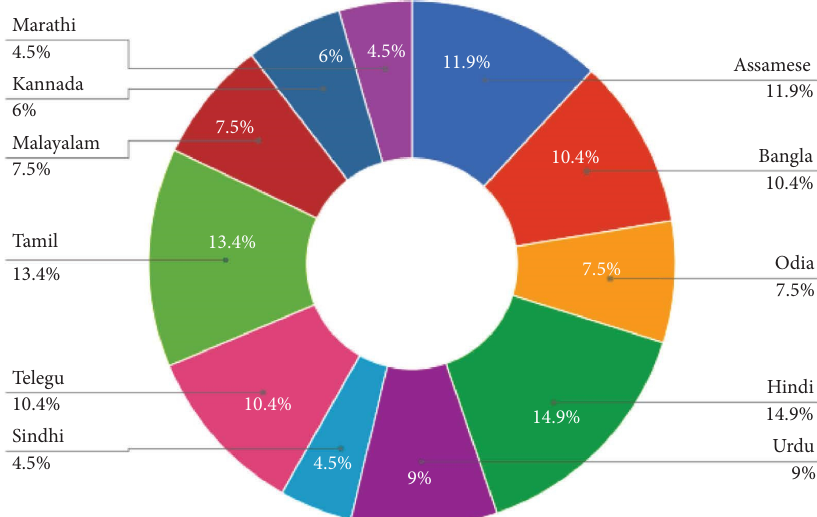
Figure 3: Analysis of SER experiments done in Indo-Aryan and Dravidian languages based on publication number in the last two decades according to Google Scholar around the time this article was